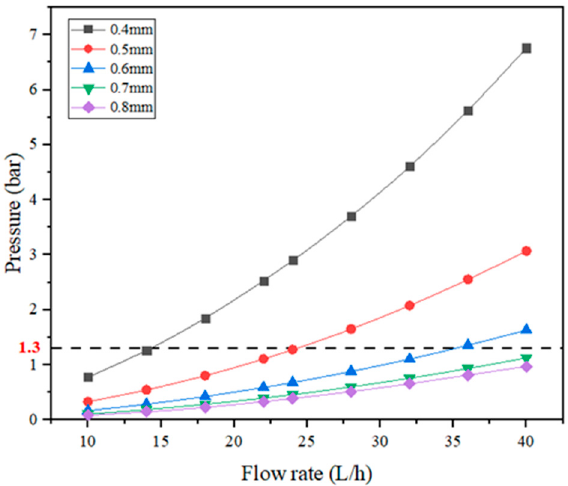
Figure 10. Variation curve of inner pressure of double-layer microchannel heat sink tube with cool- ant flow under different hydraulic diameters.